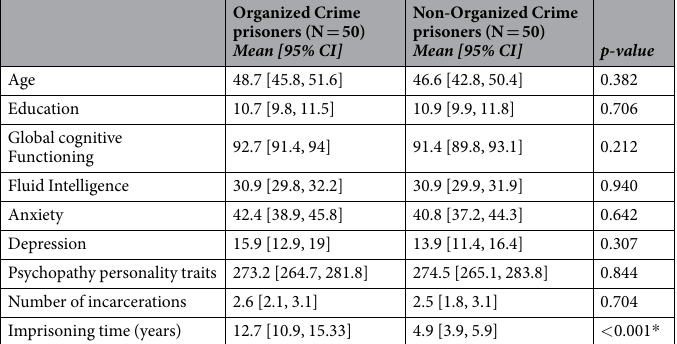
Table 1. Demographic data, global cognitive functions, and psychological